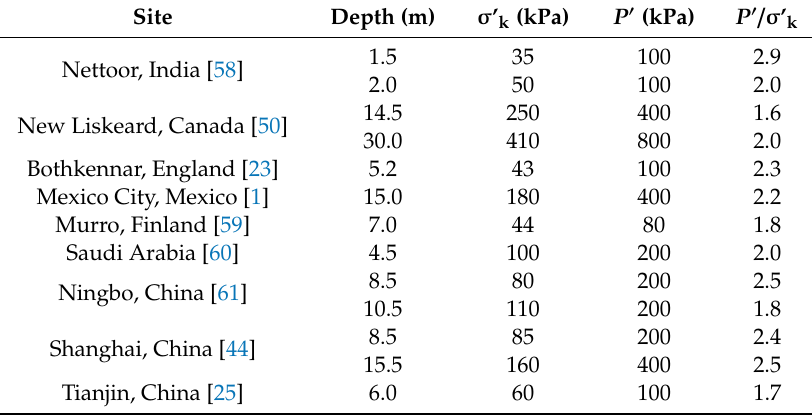
Figure 14. C α at varied vertical e ff ective stress σ v ’ of Shanghai soft soil after [44]. Table 10. A summary of σ ’ k and P (cid:48) from di ff erent